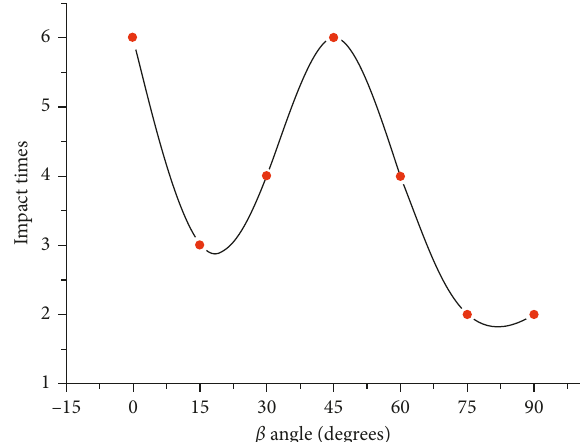
Figure 7: Impact times in final crack propagation path forms when β 0 ° , 15 ° , 30 ° , 45 ° , 60 ° , 75 ° , and 90 ° (cid:31)